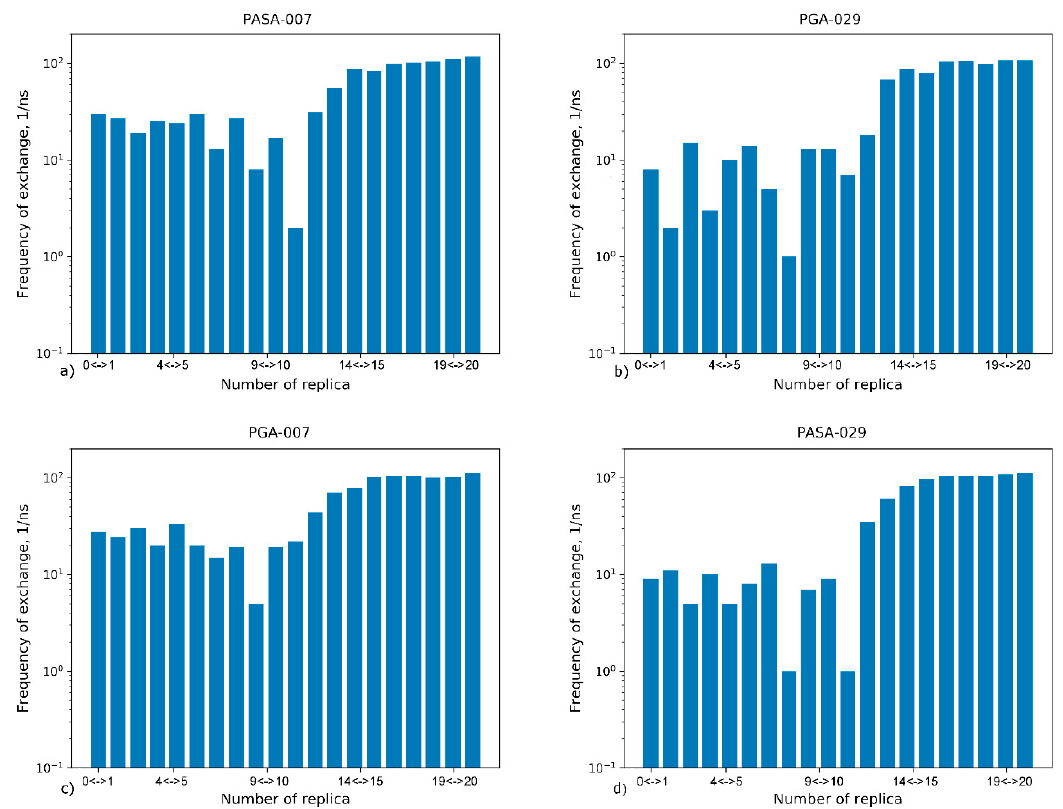
Figure 5. The exchange frequencies between neighbor replicas for all considered systems ( a ) PASA-0.07 mol/kg CaCl 2 ( b ) PASA-0.29 mol/kg CaCl 2 ( c ) PGA-0.07 mol/kg CaCl 2 ( d ) PGA-0.29 mol/kg CaCl 2